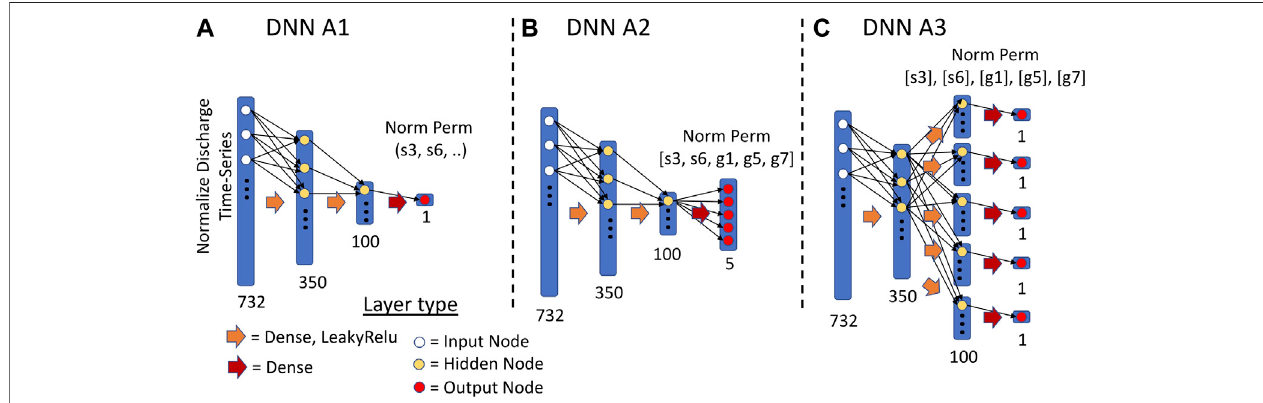
FIGURE 1 | Illustration of three DNN architectures. (A) The DNN A1 architecture; (B) The DNN A2 architecture; (C) The DNN A3 architecture. The input to each of themodelsisthenormalizeddischargetime-seriesdata(see Sections4.1 and 4.2 ).TheoutputfromDNNA1isasinglenormalizedpermeabilityparameter.Theoutputs from DNN A2 and A3 are fi ve normalized permeability